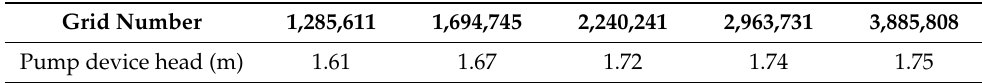
Table 1. Pump device heads under different grid numbers.